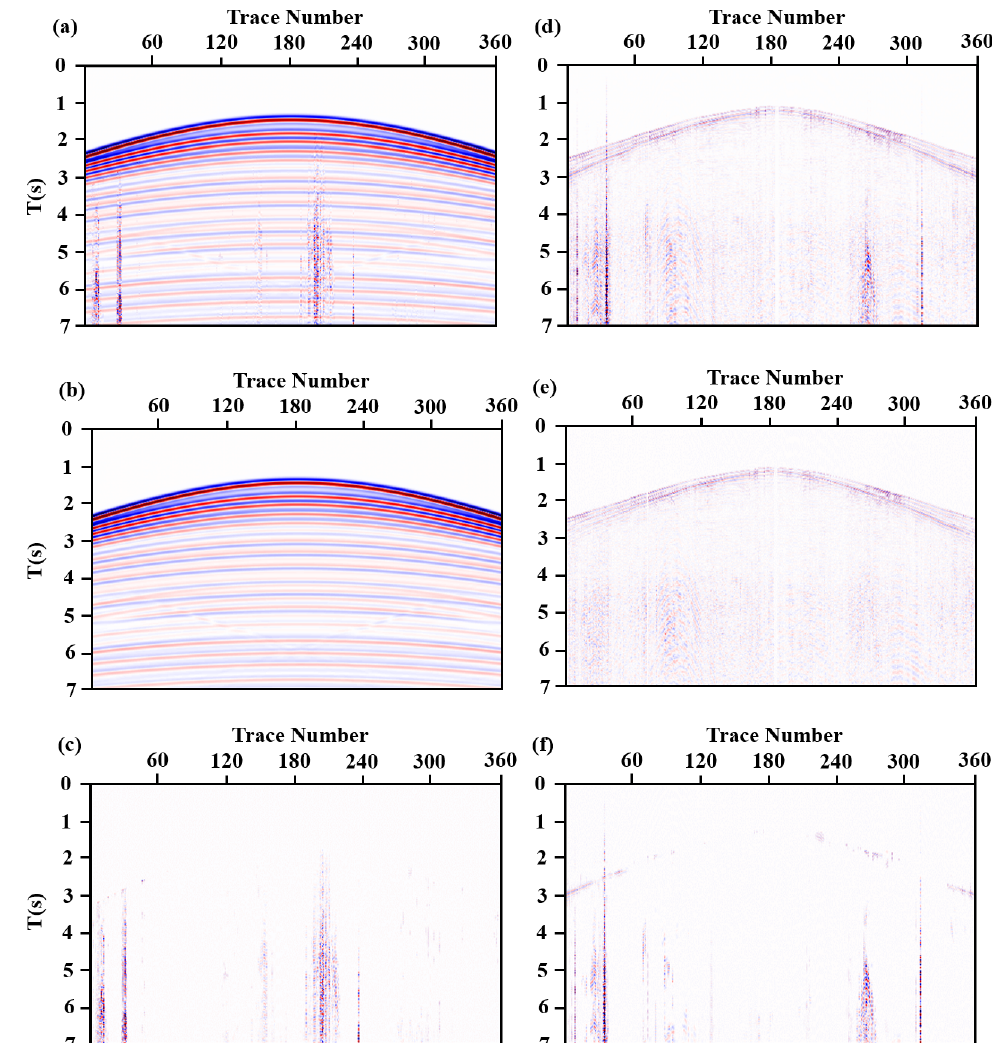
Figure 4. Training samples of synthetic data: ( a ) synthetic data with noise; ( b ) denoised synthetic data; and ( c ) traffic noise; training samples of real data: ( d ) real data with noise; ( e ) denoised real data; and ( f ) traffic